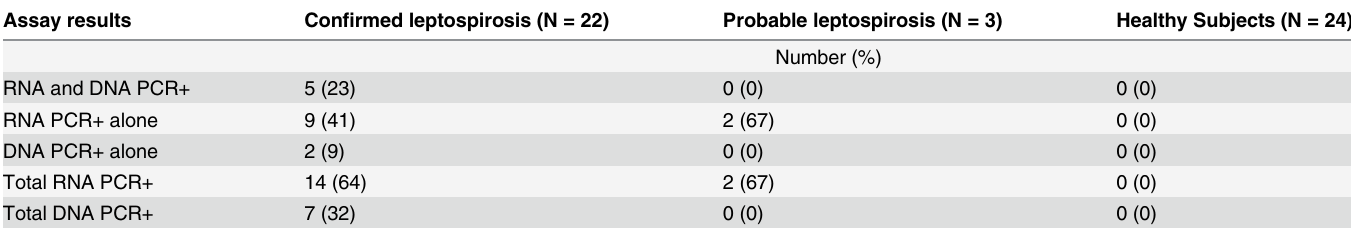
Table 1. Detection of leptospiral RNA by quantitative PCR in blood samples collected from humans with suspected leptospirosis. Assay